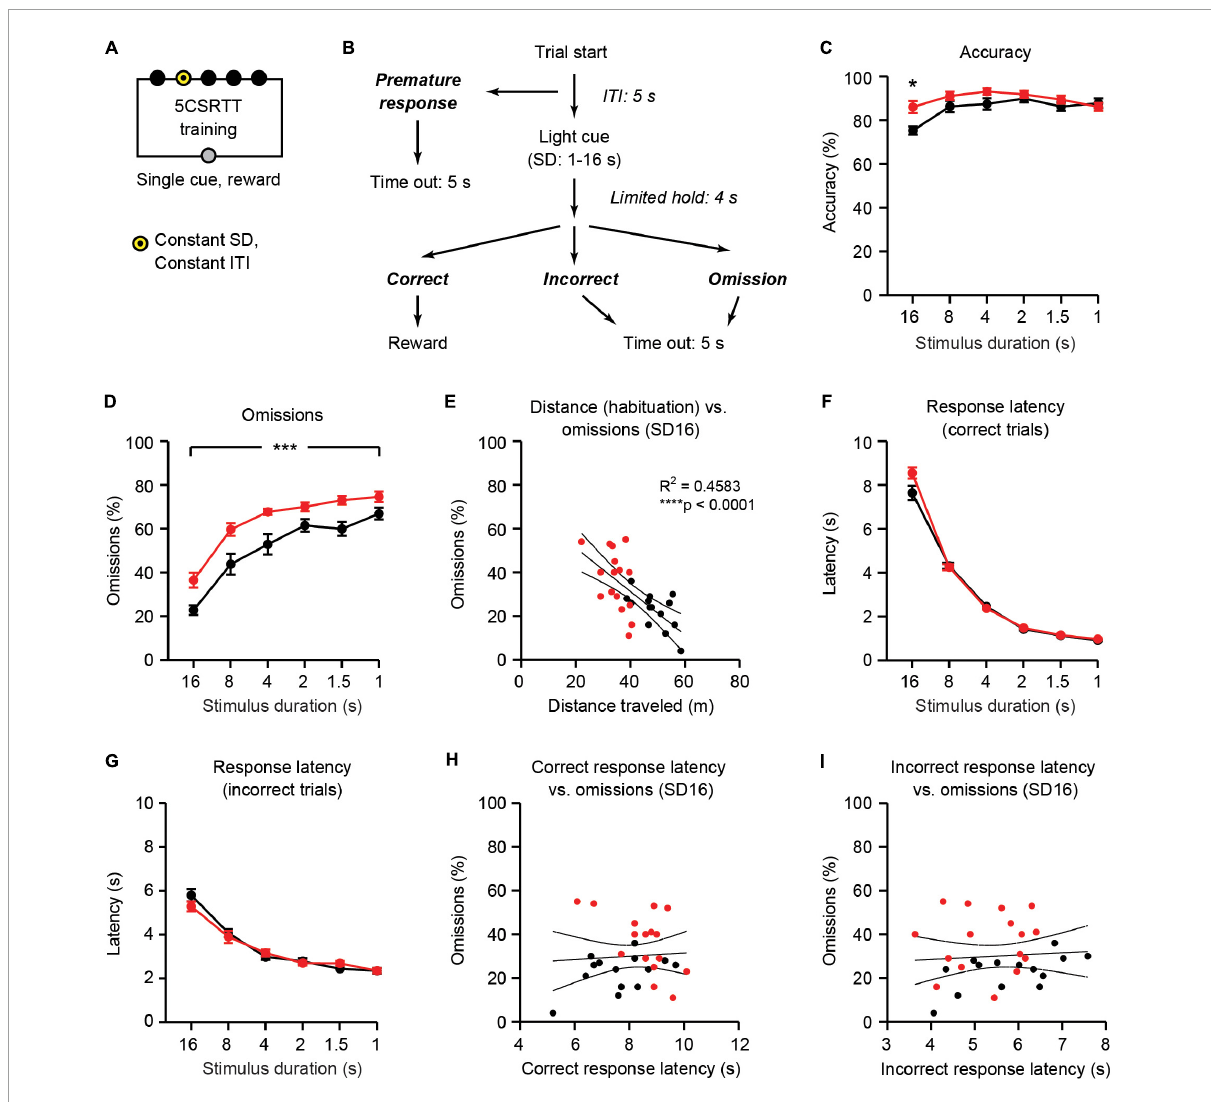
FIGURE4 Ube3a m − / p + mice have increased omissions and motor impairments during 5CSRTT training. WT: black, n = 14. Ube3a m − / p + (AS): red, n = 16. (A) Schematic of 5CSRTT training. SD: stimulus duration, ITI: intertrial interval. (B) Trial structure for individual trials (adapted from Asinof and Paine, 2014). (C) Accuracy [correct/(correct + incorrect)] on the final session at each stimulus duration. (D) Omissions during 5CSRTT training are increased in Ube3a m − / p + mice. (E) Distance traveled during habituation is negatively correlated with omissions. (F) Response latency